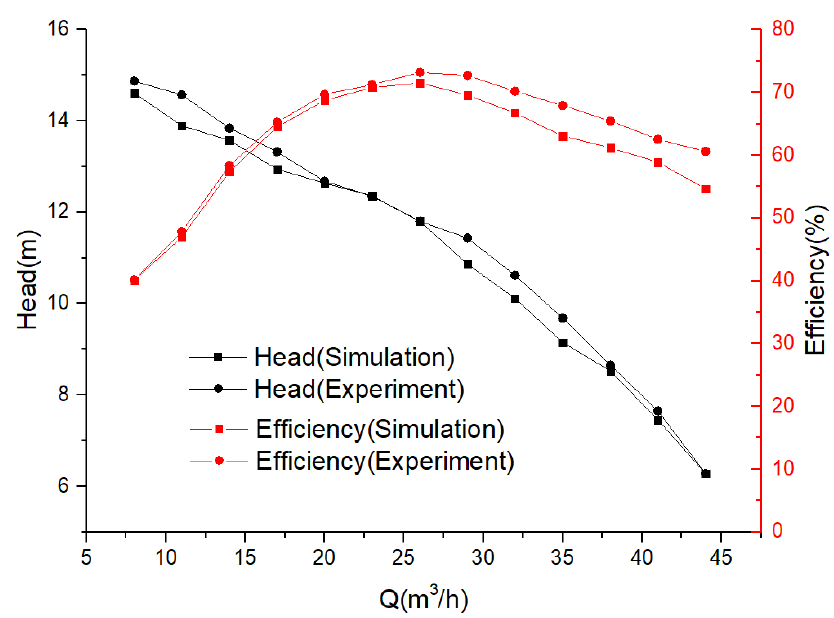
Figure 5. Pump performance curve comparison under pure water conditions.